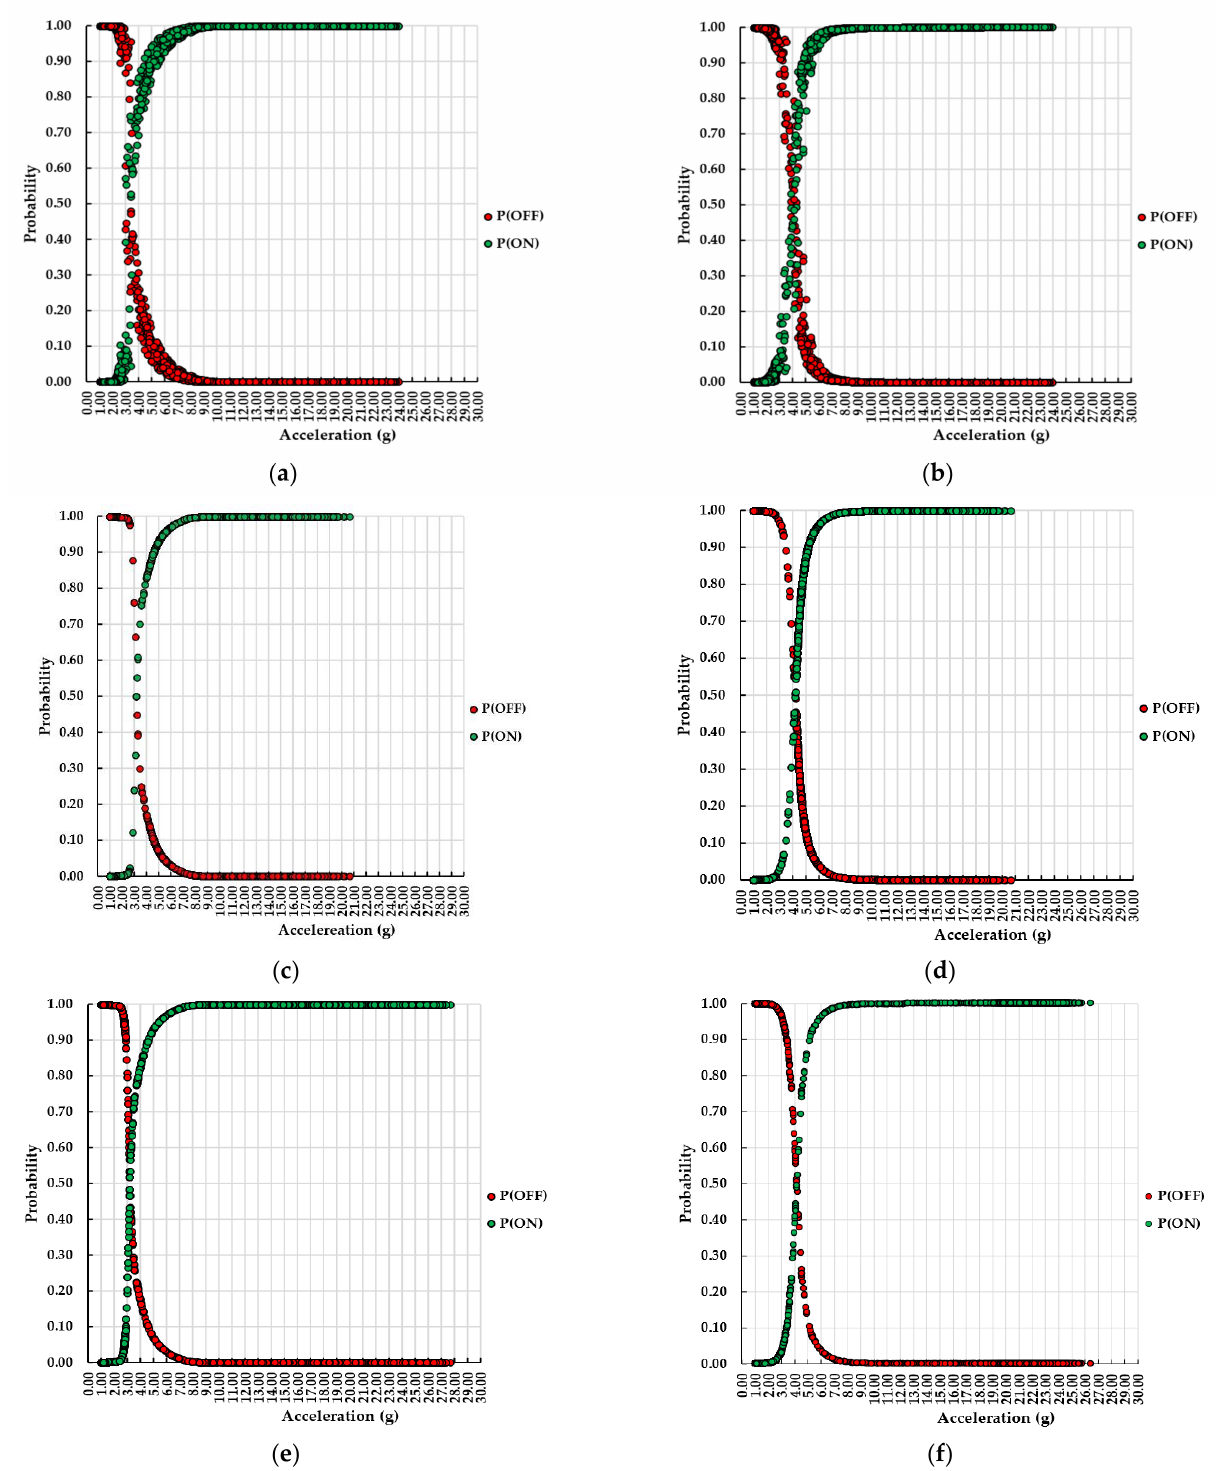
Figure 6. Selected plots showing the predicted classification probability. Legend: P(OFF), shown in red, stands for the predicted probabilities of the datapoints being OFF and P(ON), shown in green, stands for the predicted probabilities of the datapoints being ON. Note: ( a , b )—predicted classification probability for the TRAIN dataset; ( c , d )—predicted classification probability for the TEST_E2 dataset; ( e , f )—predicted classification probability for the TEST_S1 dataset; left figure panels show the data for α = 0.0001 and the right figure panels show the data for α = 0.1.